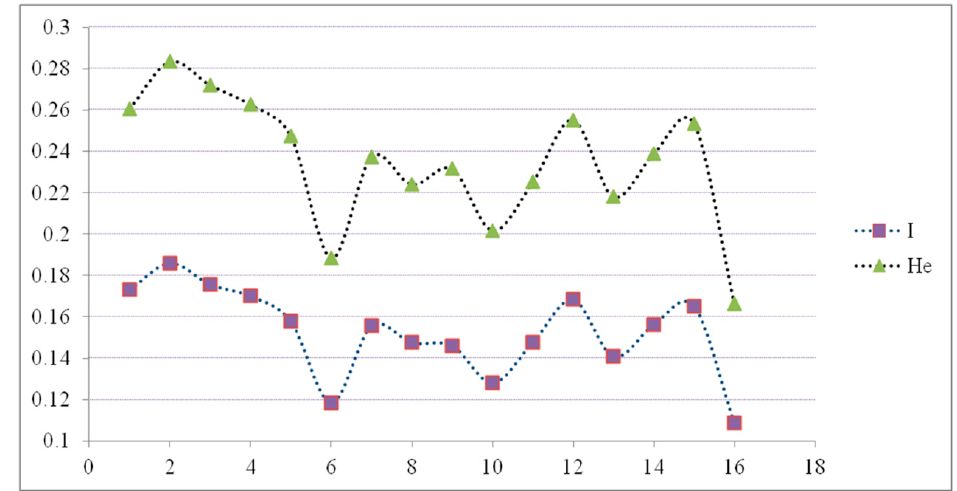
Figure 2. Within-population genetic diversity of 16 C. dactylon populations along latitudinal gradients